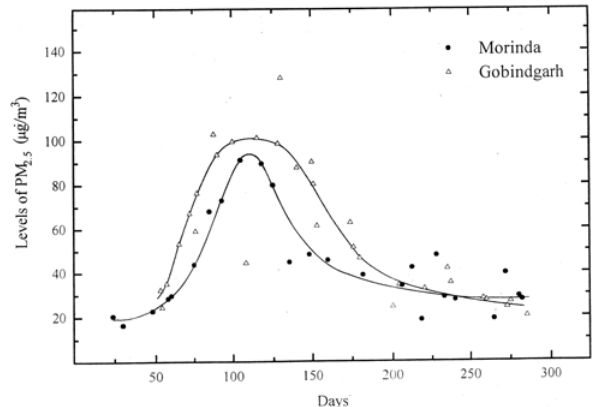
in the two study 2.5